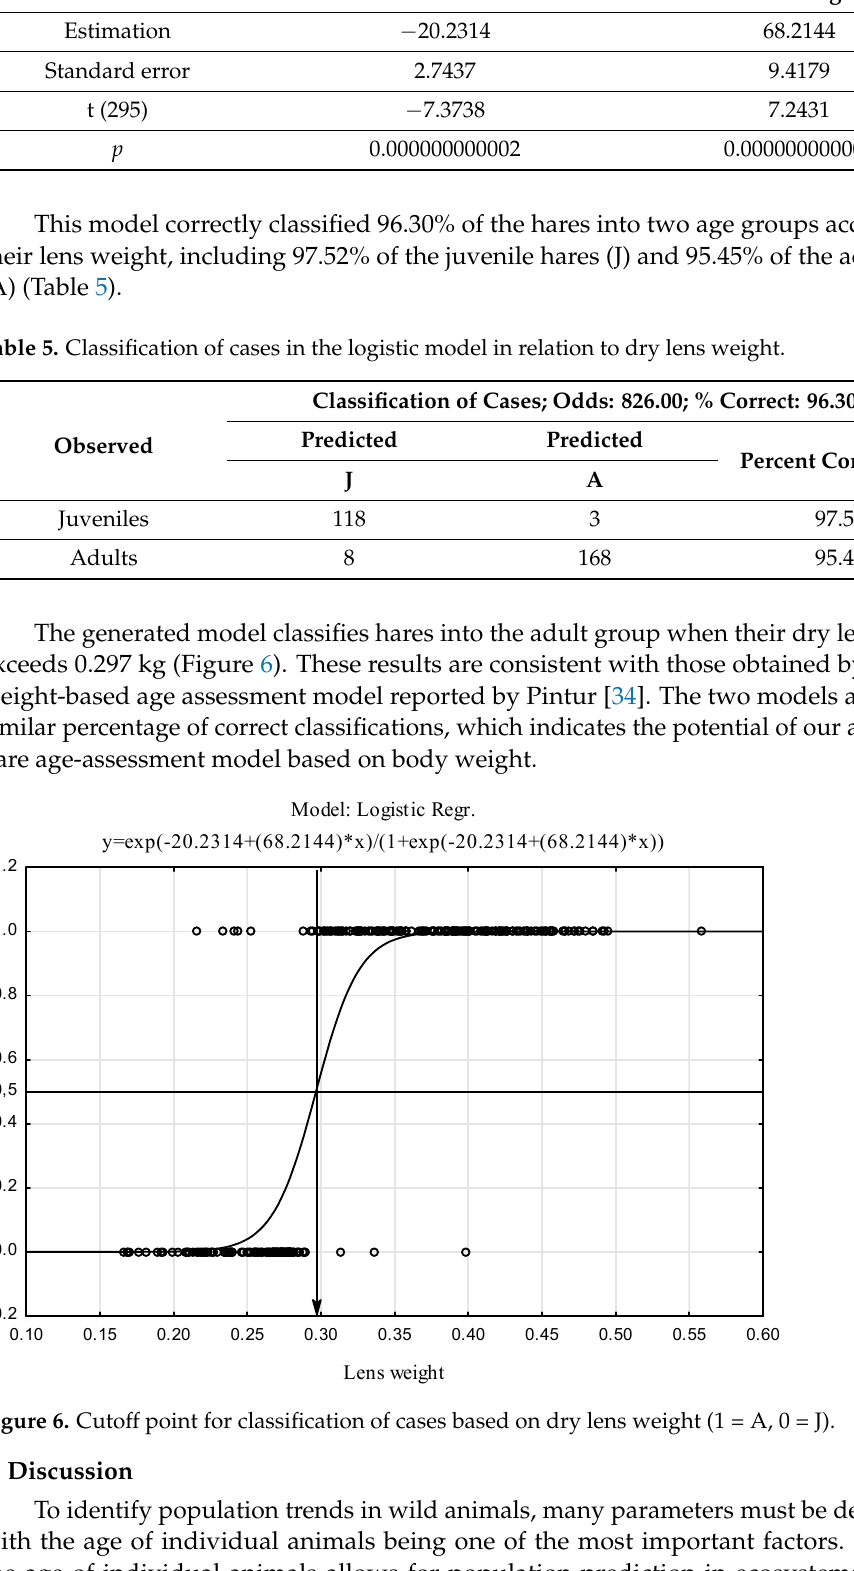
Table 4. Parameter evaluation in the logistic regression model in relation to dry lens weight. N = 297